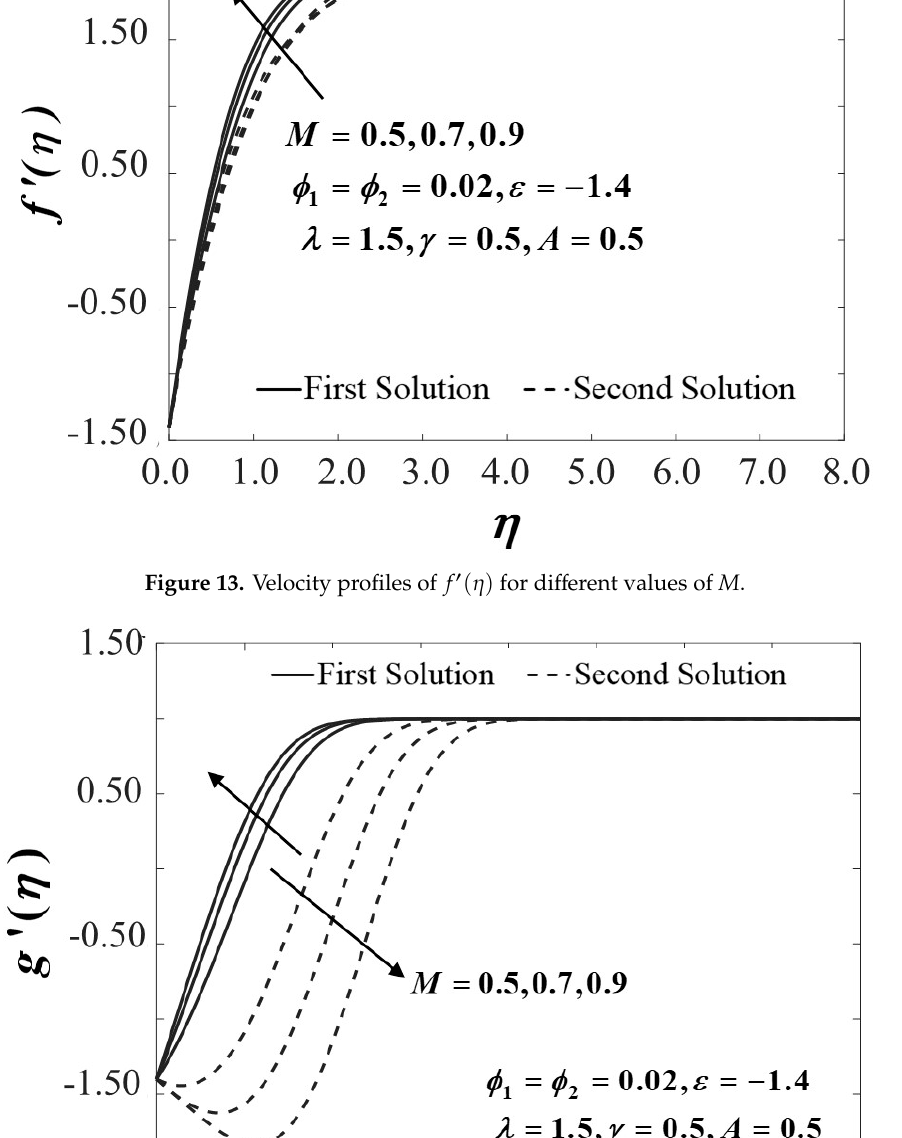
Figure 14. Velocity profiles of g (cid:48) ( η ) for di ff erent values of M